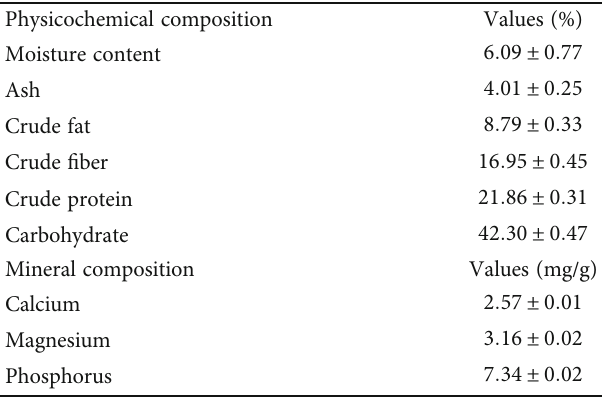
Table 1: Proximate and mineral composition (% dry matter) of brewery spent grain. Physicochemical